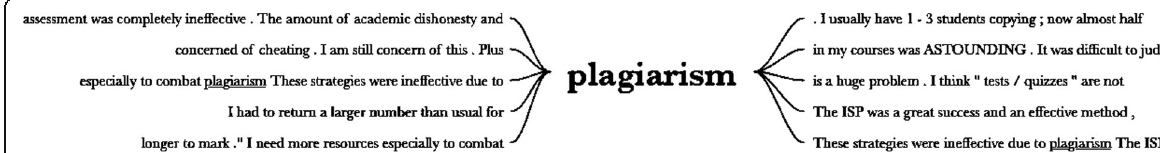
Fig. 5 NVivo 12 generated word tree highlighting teachers ’ reflections on